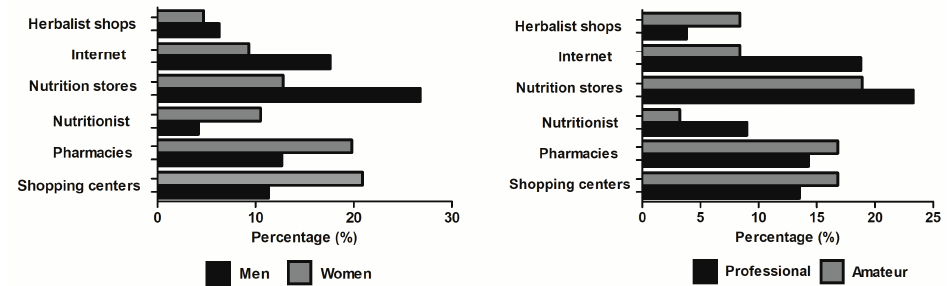
Figure 2. Main site of purchase of sports supplements in handball players according to sex (left panel) and competitive level (right panel).